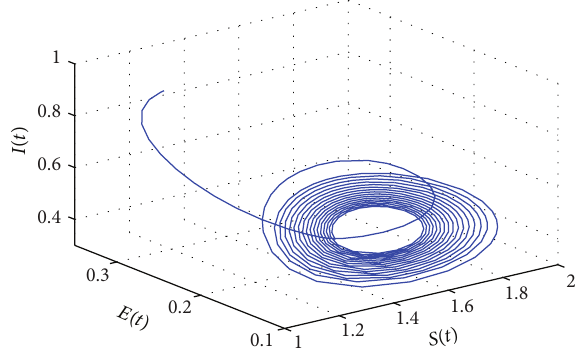
Figure 3: The phase plot of the states 𝑆 , 𝐸 , and 𝐼 for 𝜏 = 10.025 > 8.9829 = 𝜏 0 .